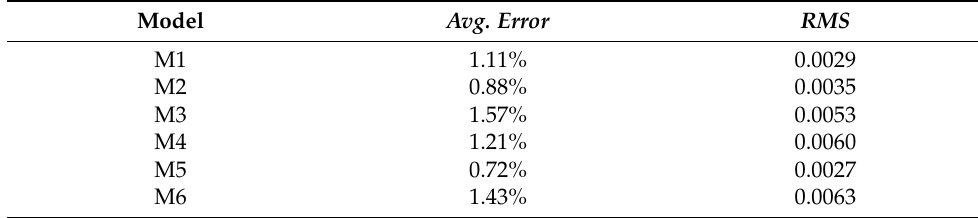
Table 2. Average error and standard deviation between simulation and experimental value for M1-M6 coiled